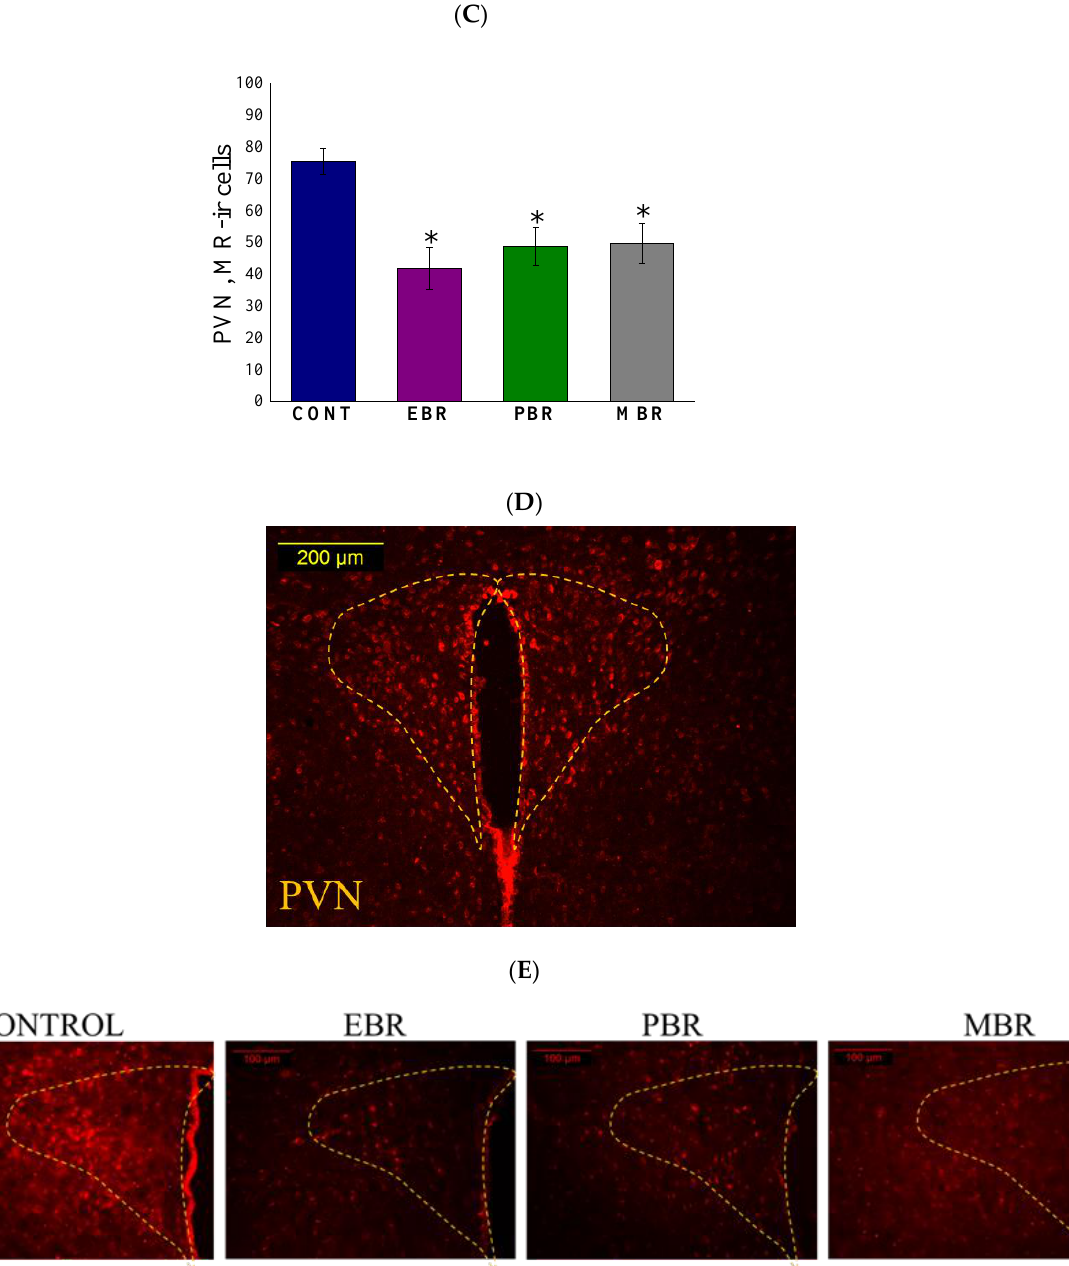
Figure 6. Brain MR-ir cells 8 days post-PSS exposure. Immunohistochemistry of MR in specific brain areas 8 days post-PSS exposure. Significant differences between dorsal and ventral parts are depicted in the graphs, whereas notations are given for significant differences between groups in the same area and explained in this legend for each graph separately. ( A ) MR-IR in the CA1 region of the ventral and dorsal hippocampus [* significant as compared to dorsal control and MBR ( p < 0.03); ** significant as compared to ventral control and MBR ( p < 0.045)]. ( B ) MR-IR in the ventral and dorsal dentate gyrus [* significant as compared to dorsal control, PBR and MBR ( p < 0.02); ** significant as compared to ventral control ( p < 0.001); @ significant as compared to ventral EBR and PBR ( p < 0.02)]. ( C ) MR-IR in the PVN [* significant compared to control ( p < 0.015)]. Panel ( D ) shows a schematic drawing of the regions of the PVN from which the measurements were collected. The image was acquired at 10 × magnification. Scale bar: 200 µ m. Additionally, in ( E ), there are representative images of MR-immunoreactivity in the PVN region of CONT, EBR, PBR, and MBR groups. Images were acquired at 20 × magnification. Scale bar: 100 m. The cells in red are MR-positive.